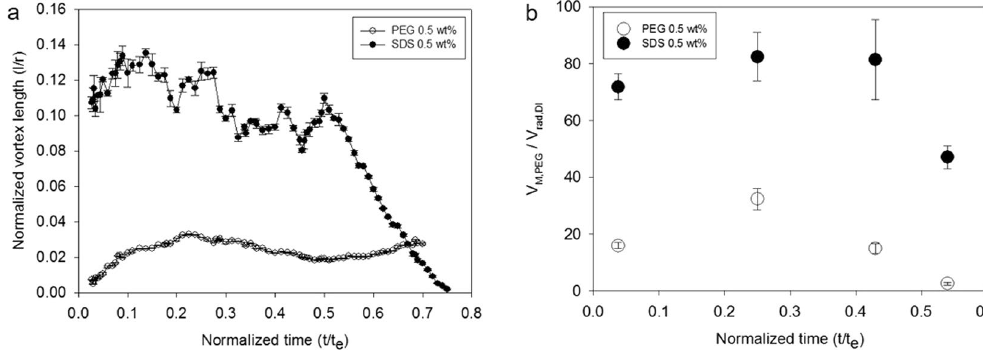
Figure 5. Characterization of Marangoni vortex. ( a ) Comparison of Marangoni vortex between SDS and PEG droplet, ( b ) Variation of Marangoni vortex velocities for SDS and PEG